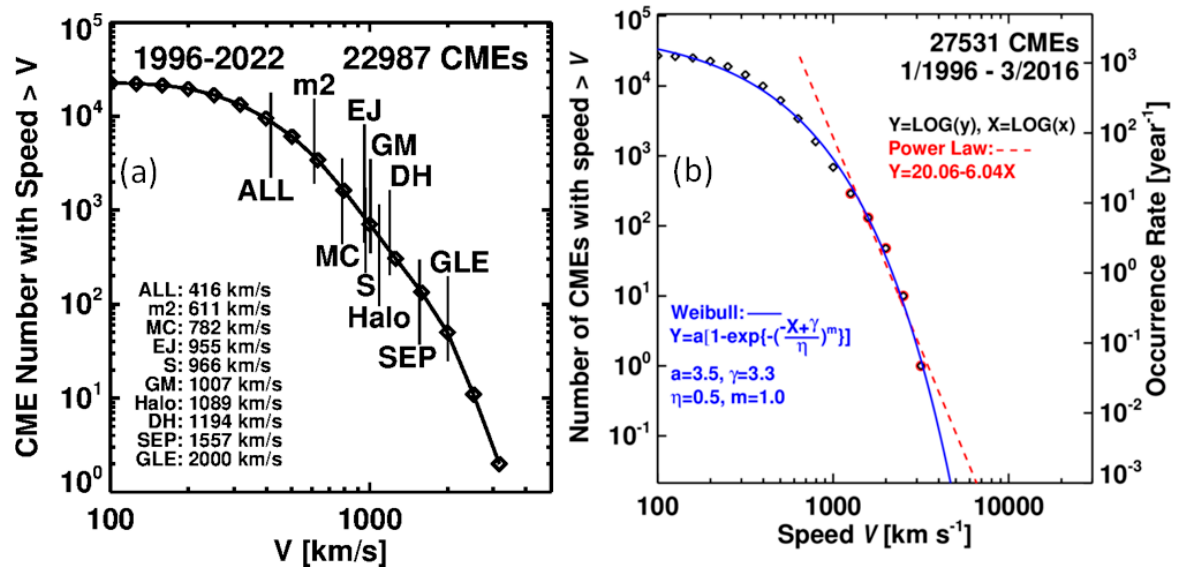
Figure 25. ( a ) Cumulative distribution of CME sky–plane speeds (V) from https://cdaw.gsfc.nasa.gov/CME_list, (accessed on 1 October 2022), with the average speeds of various CME populations. The original data is binned into 5 data points per decade. ( b ) Weibull (blue) and power law (red) fits to the CME speed distribution. Updated from [191].